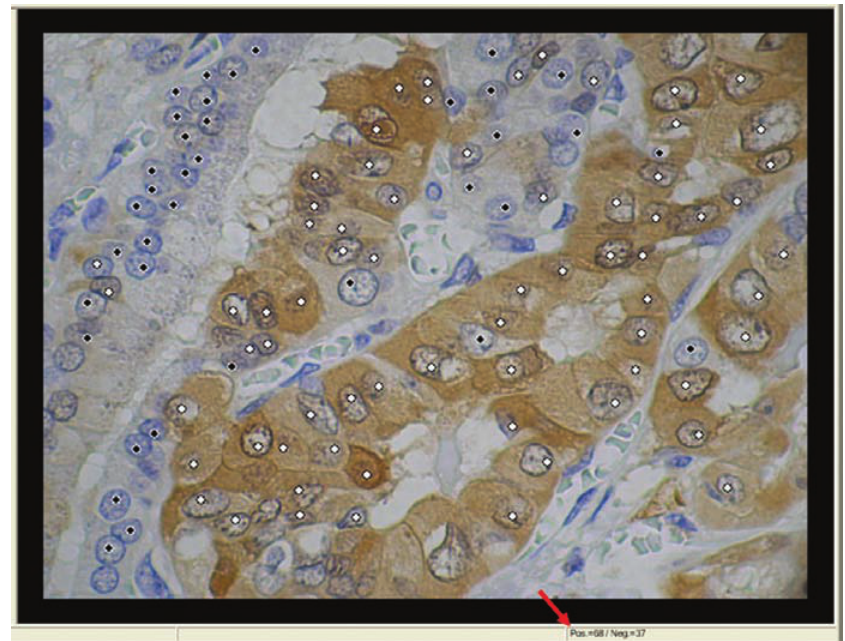
Figure 1 - Demonstration of ImageLab ® software in the identification of positive labeled cells (white spots) and negative cells (black spots). The calculation of PLC is indicated by the DIG